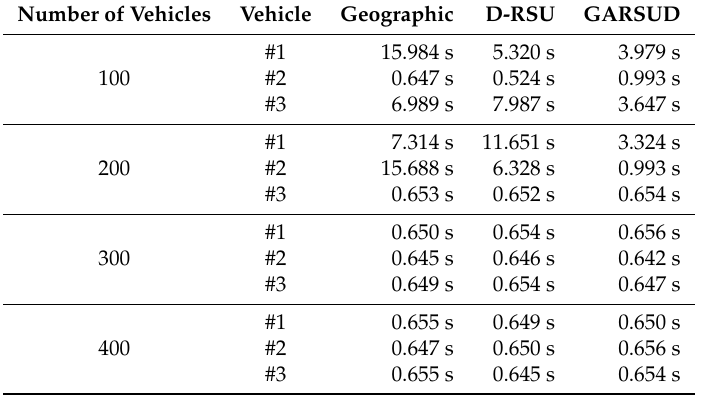
Table 6. Warning notification time (in seconds) for each warning vehicle when deploying 9 RSUs in Madrid considering a uniform traffic